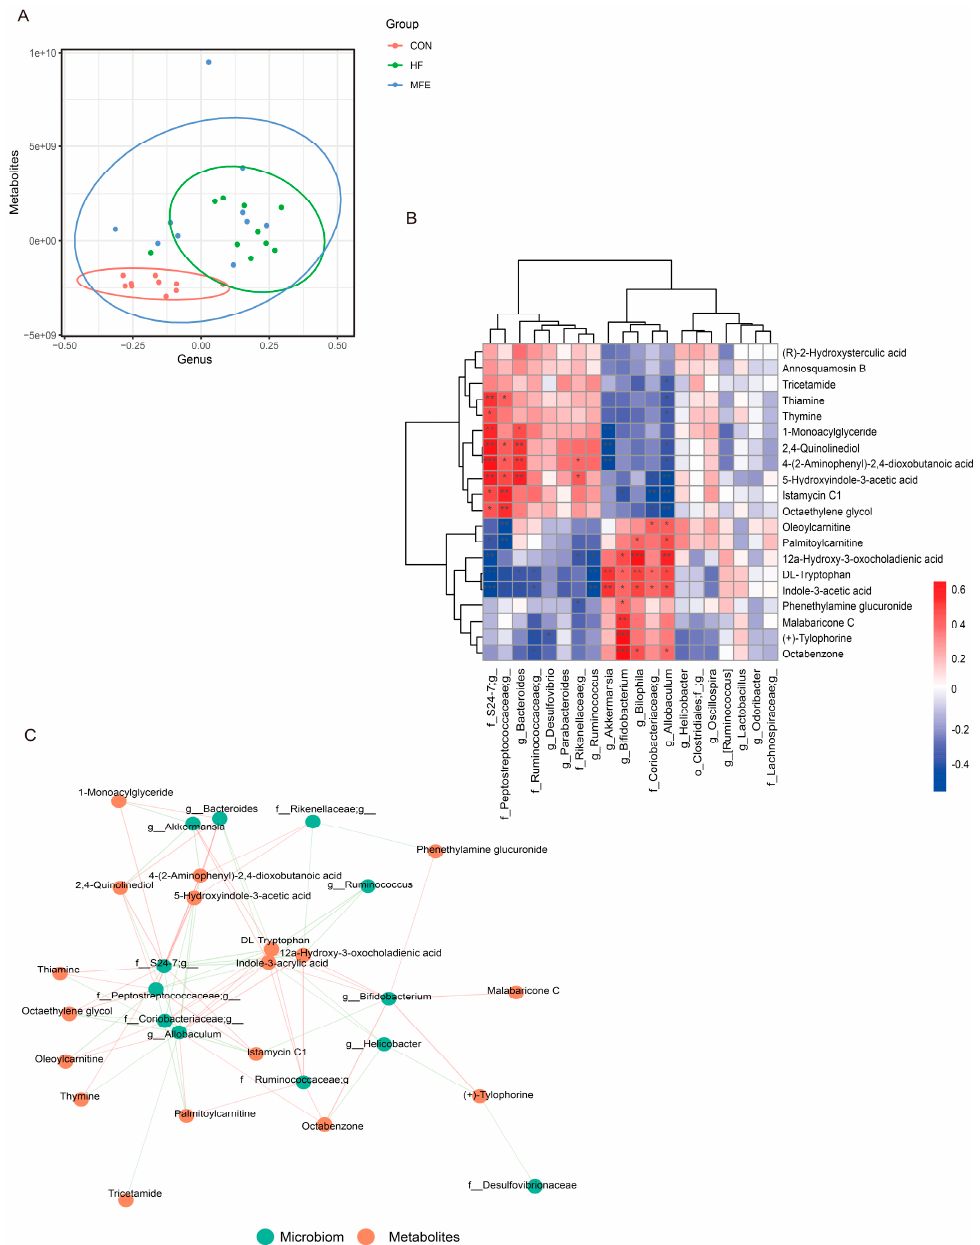
Figure 5. Omics analysis of the intestinal flora metabolites in NAFLD mice with MFE treatment. ( A ) PLS-DA (Partial Least Squares Discriminant) Analysis of intestinal microbes at genus level and metabolites. (Variable Importance for the Projection, VIP > 1) ( B ) Heat map of correlation analysis between intestinal microbes at genus level and metabolites in MFE group (red represents positive correlation and blue represents negative correlation). ( C ) Correlation network diagram between microbiota and metabolites in MFE group. Data are shown as mean ± SD. (For each group, n = 10, * p < 0.05; ** p < 0.01; *** p <